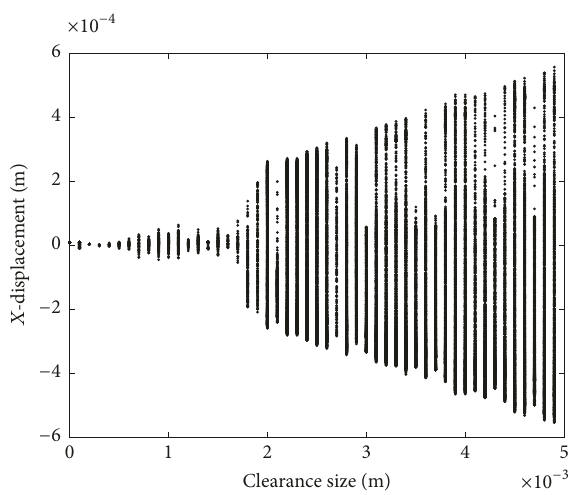
Figure 17: Bifurcation